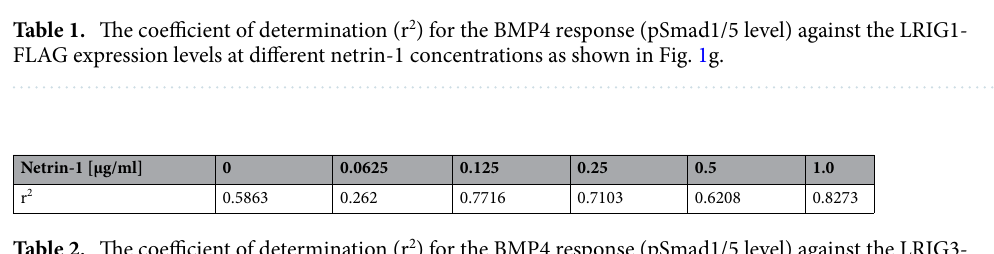
(Fig. 3c) and time-dependent (Fig. 3d) decrease in neogenin levels in both Lrig wild-type and Lrig -null MEFs. The induced expression of human LRIG1 or LRIG3 but not LRIG2 in Ntn1 wild-type MEFs resulted in increased